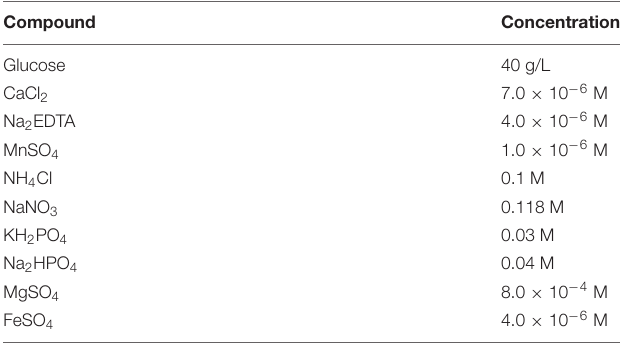
TABLE 1 | Composition of mineral salt medium used for surfactin production.